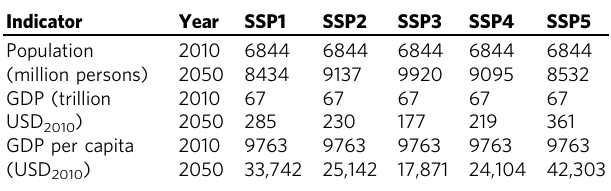
Table 3 Key global characteristics of the SSP quanti fi